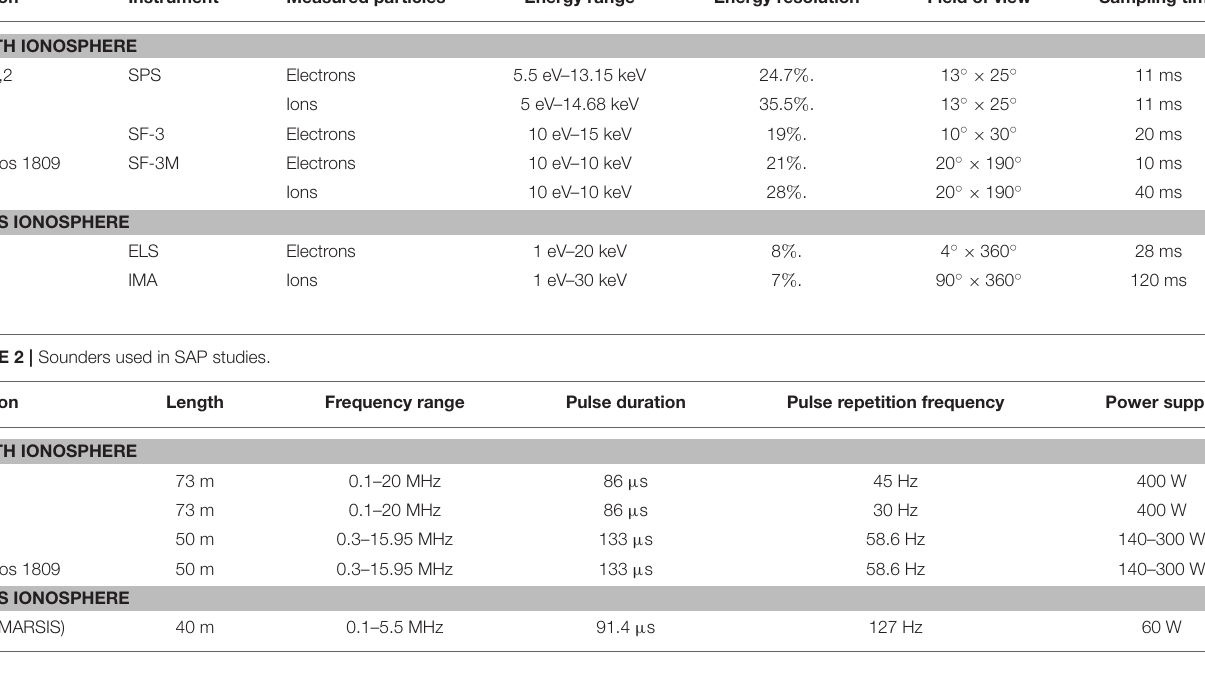
TABLE 1 | Particle detectors used in SAP studies. Mission Instrument